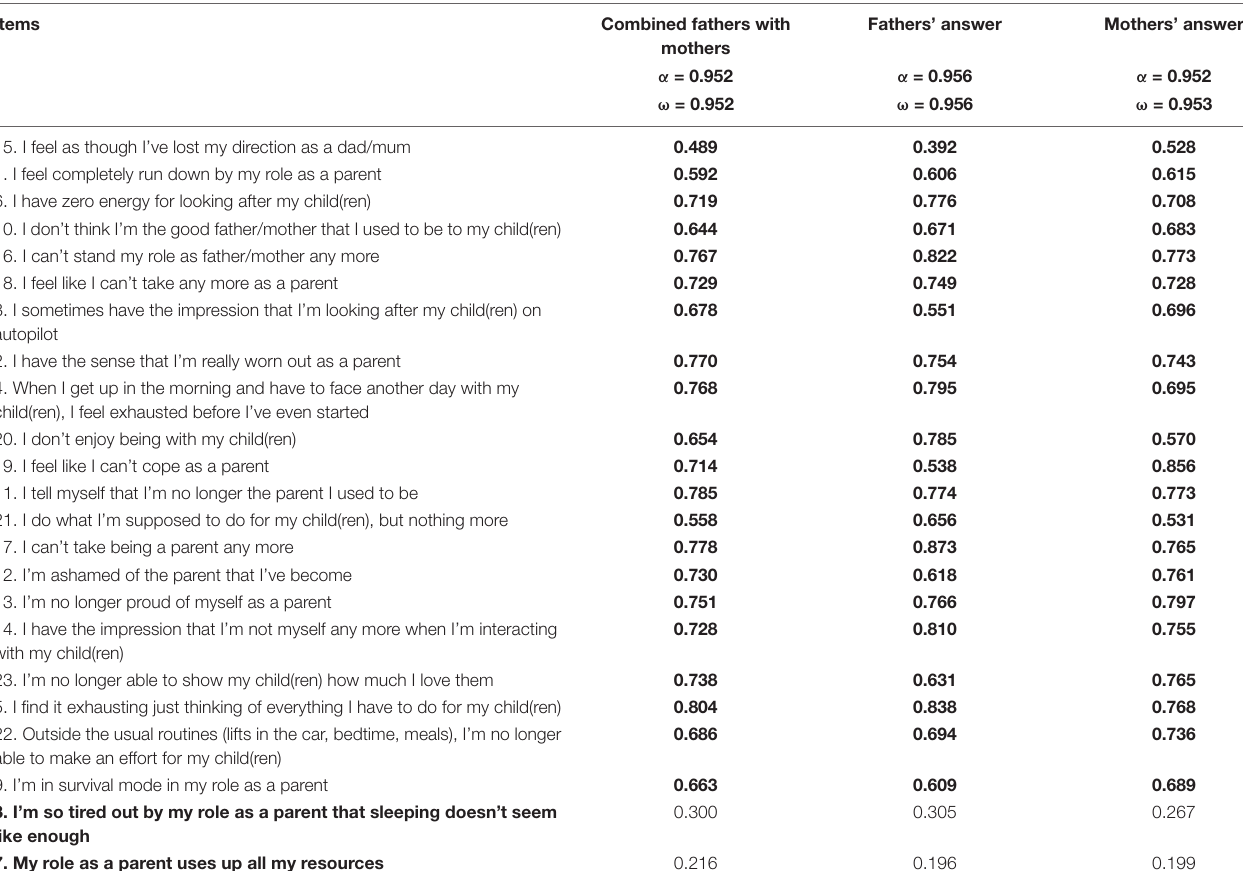
TABLE 3 | Results of the confirmatory factor analysis. Items Combined fathers with